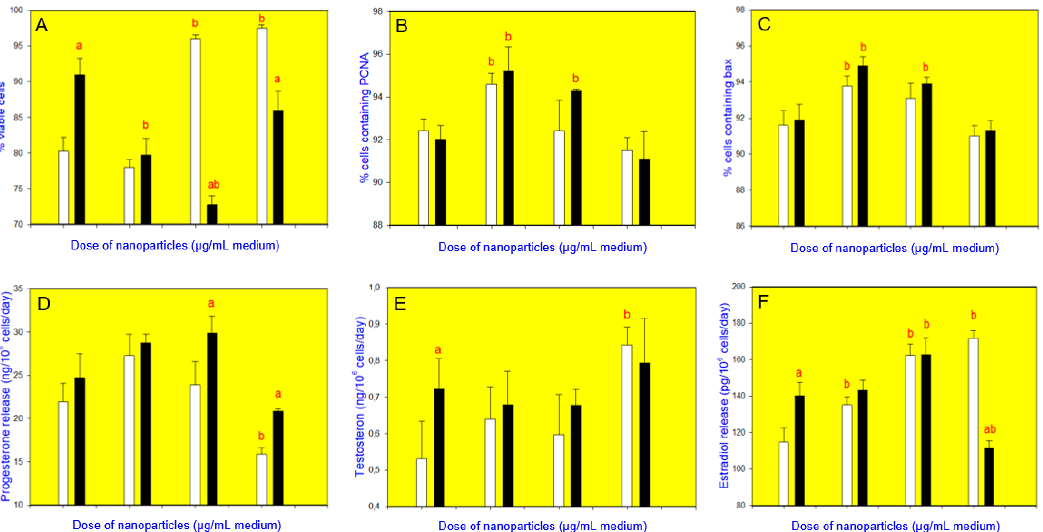
Figure 5. E ff ect of CuNPs / TiO 2 (0, 1, 10, or 100 µ g / mL) alone (white bars) and in combination with rutin (10 µ g / mL; black bars) on the viability (Trypan blue exclusion assays) ( A ), proliferation (expression of proliferating cell nuclear antigen, PCNA, quantitative immunocytochemistry) ( B ), apoptosis (expression of bax, quantitative immunocytochemistry) ( C ), and secretion of progesterone (enzyme-linked immunosorbent assay, ELISA) ( D ), testosterone (ELISA) ( E ), and 17 β -estradiol (ELISA) ( F ) in cultured porcine ovarian granulosa cells. The values are expressed as the mean ± SEM; a: e ff ect of rutin–significant ( p < 0.05) di ff erences between the corresponding groups of cells, treated and untreated with rutin and b: e ff ect of CuNPs / TiO 2 –significant ( p < 0.05) di ff erences between the cells, treated and untreated with CuNPs / TiO 2 .